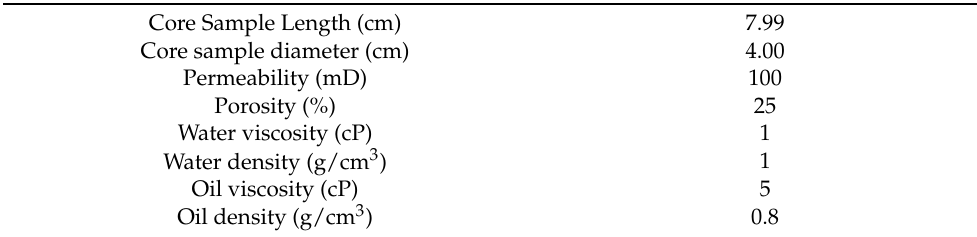
Table 3. Fluid and core sample properties for verification case.